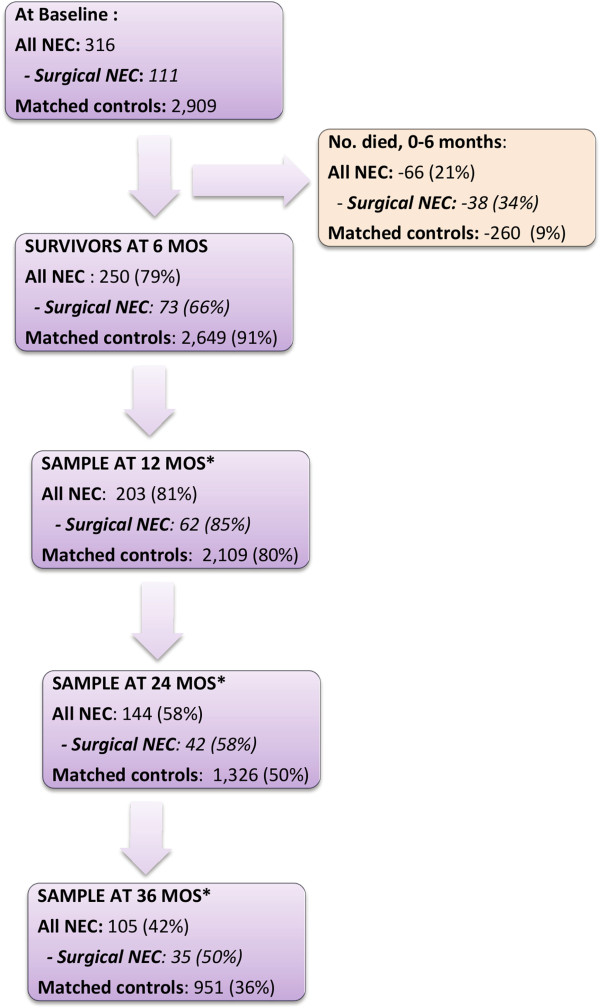
NEC and control group sample sizes (after matching) from 6 months to 3 years of age.